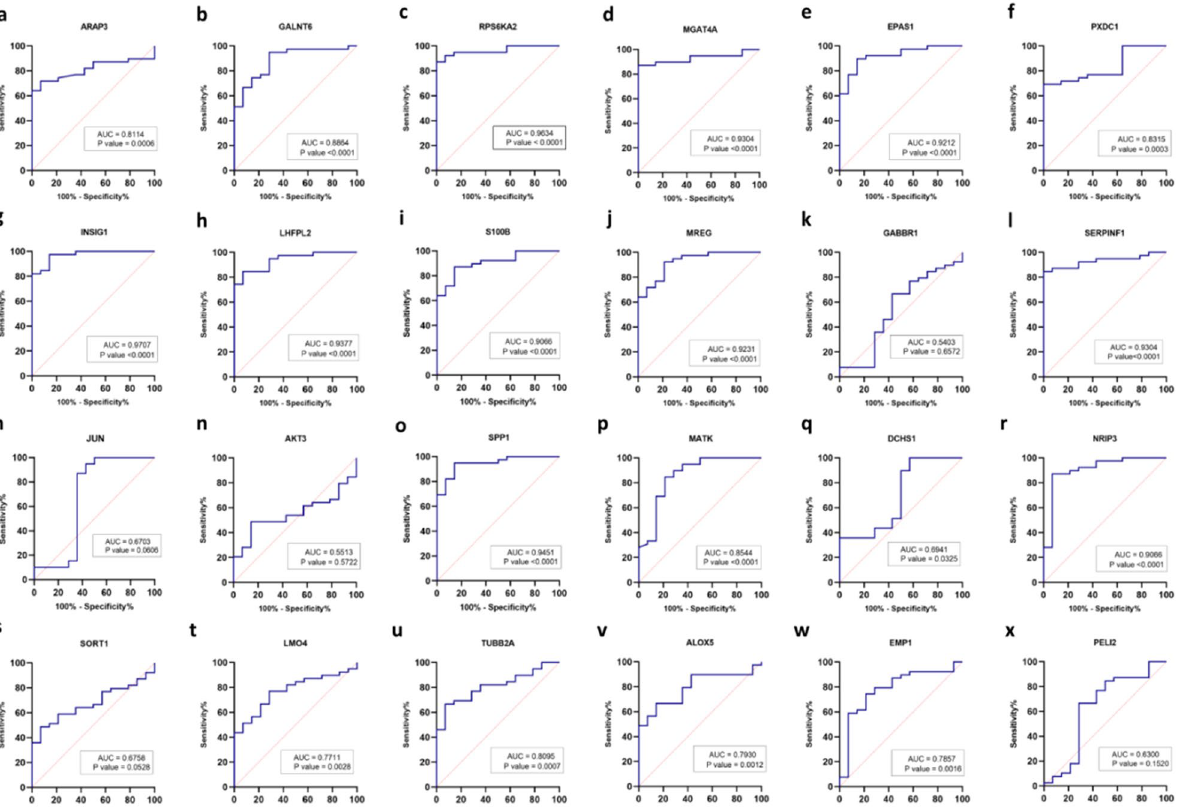
Figure 6. ROC curve analysis for DEGs. Receiver operating characteristics (ROC) curve was constructed and performed using GraphPad.Prism.9 (https:// www. graph pad. com) to assess the predictive accuracy of gene signature for AML chemo-resistance. The AUC value was 0.7 demonstrating predictive power of the identified